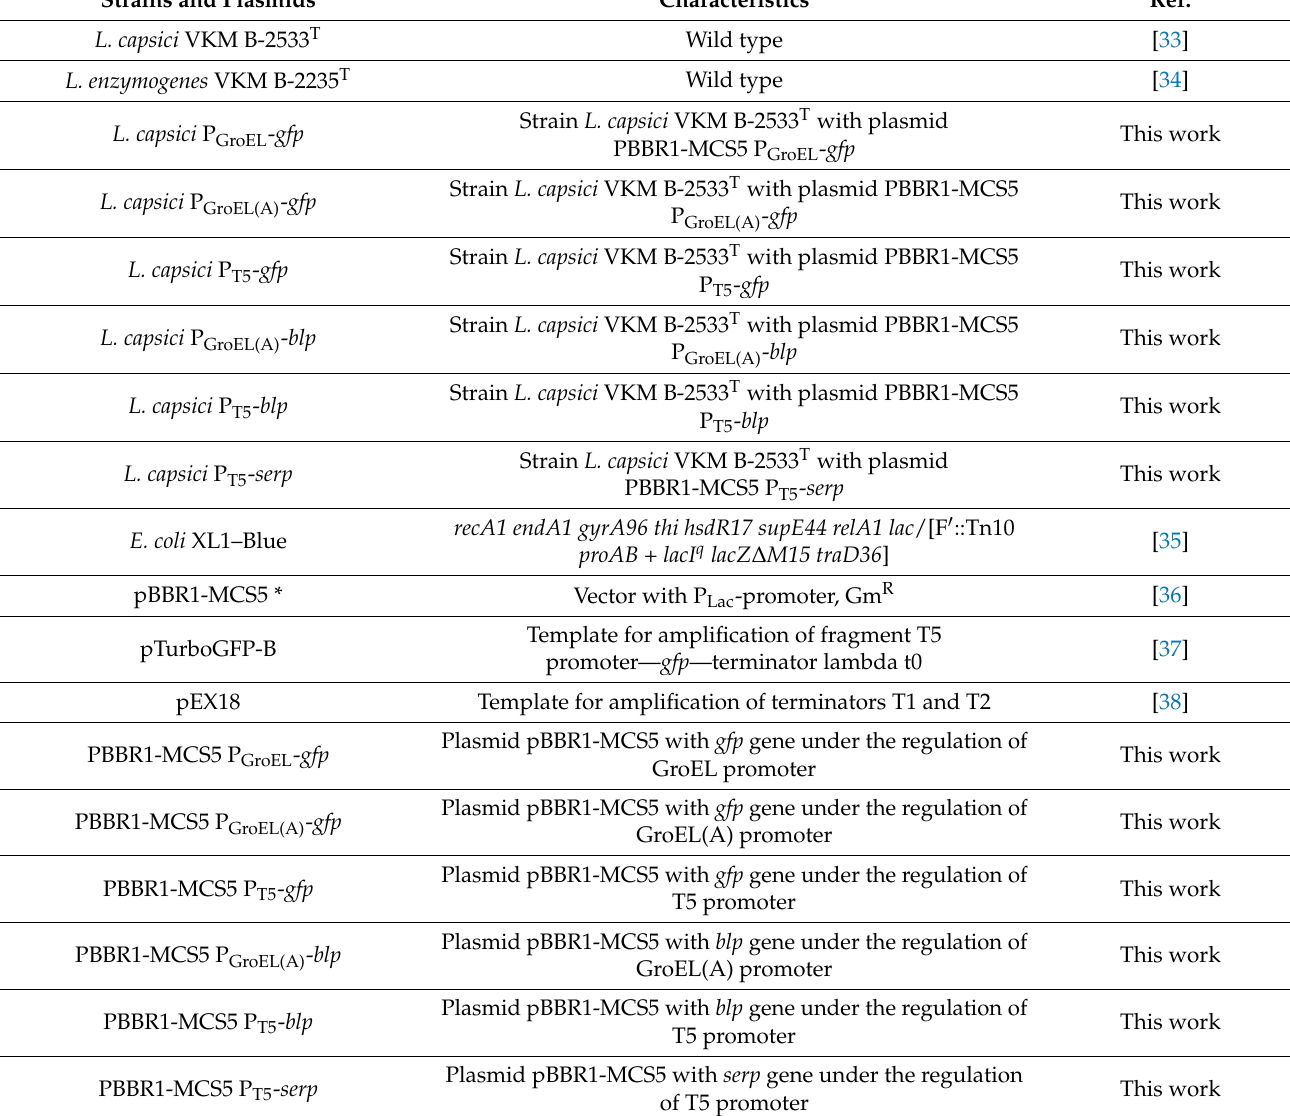
Table 3. Strains and plasmids used in the